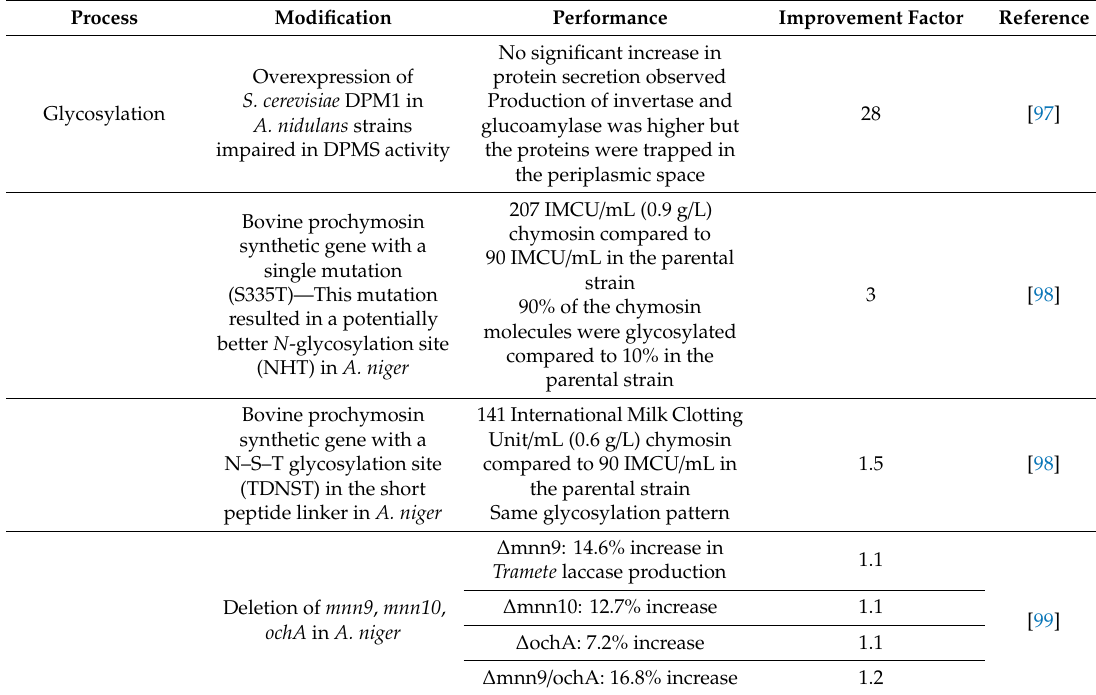
Table 6. Approaches for improving recombinant protein production through engineering